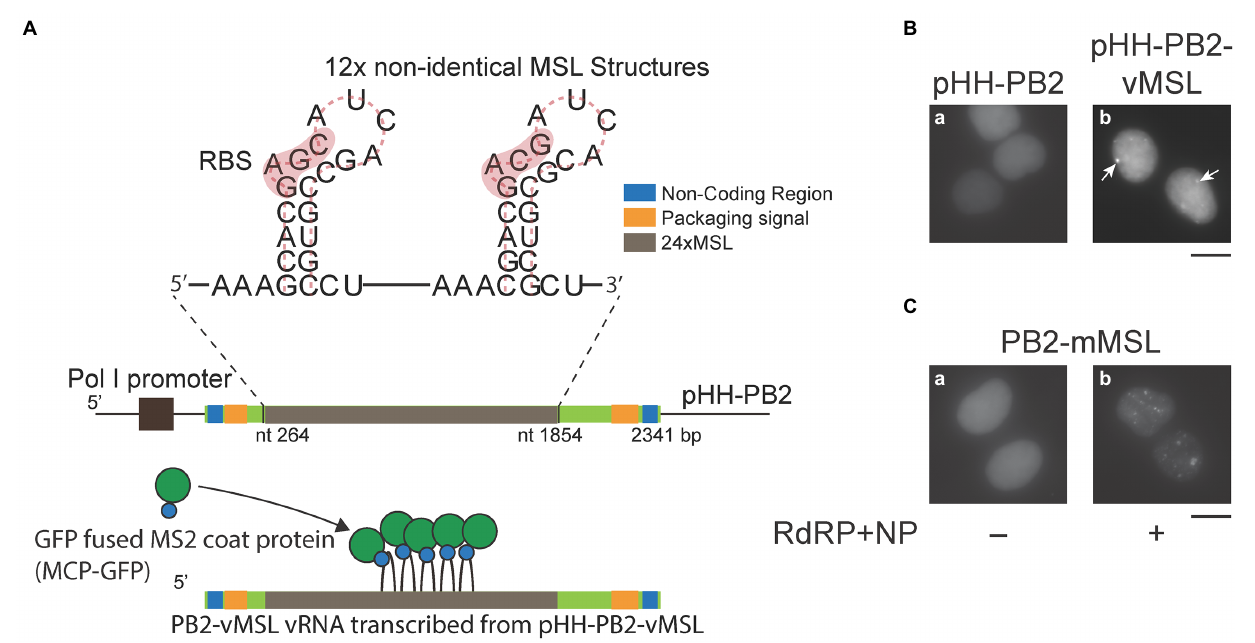
FIGURE 1 | An imaging system for visualizing influenza A virus (IAV) vRNA. (A) Twelve copies of a DNA fragment encoding two tandemly located non-identical MSL structures, which contain a ribosomal-binding site (RBS) and the translation initiation codon of the MS2 bacteriophage replicase gene, were used to replace a portion of the PB2 gene in pHH-PB2 to generate pHH-PB2-vMSL. PB2-vMSL vRNA is transcribed from the RNA polymerase I (POL I) promoter, and the MSL structures can be bound by MCP-GFP fusion protein. (B) HEK293T cells were cotransfected with pMCP-GFP and (a) pHH-PB2 or (b) pHH-PB2-vMSL. Cells were fixed with paraformaldehyde and observed at 16 h after transfection. Arrows indicate punctate signals. (C) HEK293T cells were cotransfected with pMCP-GFP and (a) pHH-PB2-mMSL or (b) pHH-PB2-mMSL and plasmids expressing NP and the RdRP components PB1, PB2, and PA. Cells were fixed at 16 h after transfection. The images of representative cells were acquired under a Nikon TiE eclipse inverted microscope. Scale bar: 10 μ